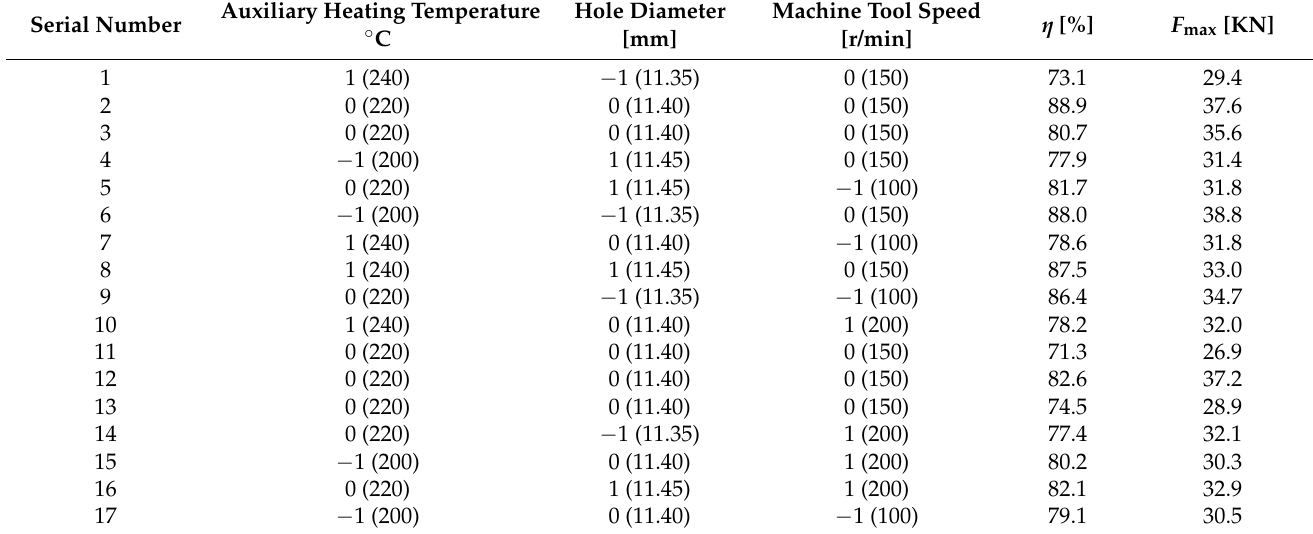
Table 4. Test plan and